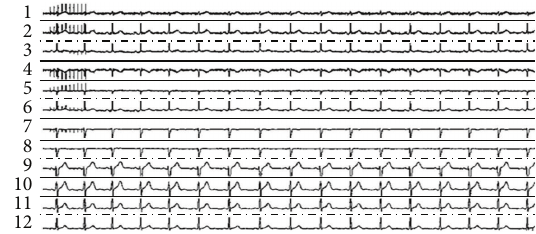
Figure 3: 12-lead ECG recording. Note: stimuli artifact (1sec, 10Hz) is seen at the beginning of recording in several